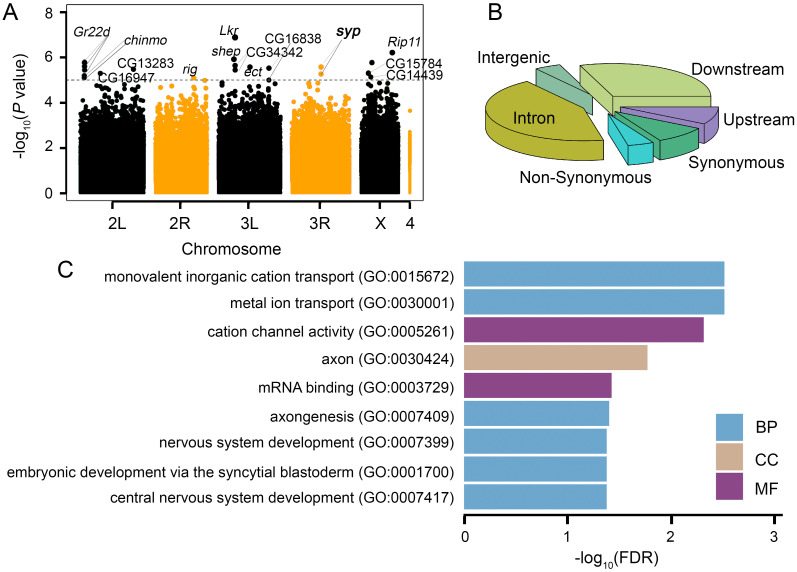
Manhattan plot for GWA, genomic location of significant SNPs, and GO analysis.(A) Manhattan plot of SIH. The gray dotted line is the significant cutoff line used for gene nomination (P < 1 × 10-5). (B) Genomic location of significant SNPs/Indels. (C) GO terms associated with more than four genes. BP: Biological Process; CC: Cellular Component; MF: Molecular Function.